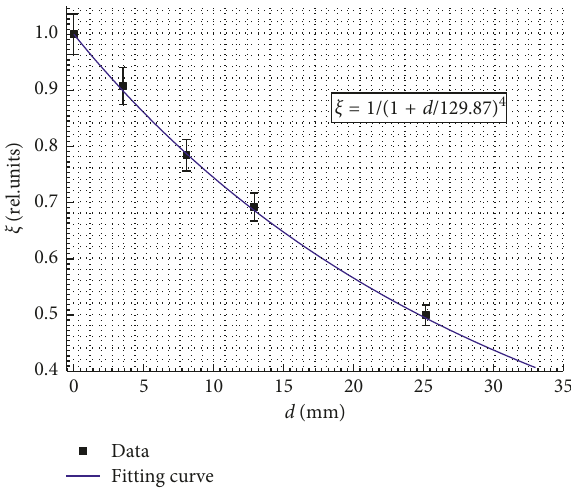
Figure 5: Intensity ratio ξ vs. crack depth d and fitting curve ξ � 1/ ( 1 + ( d /129 . 87 )) 4 .